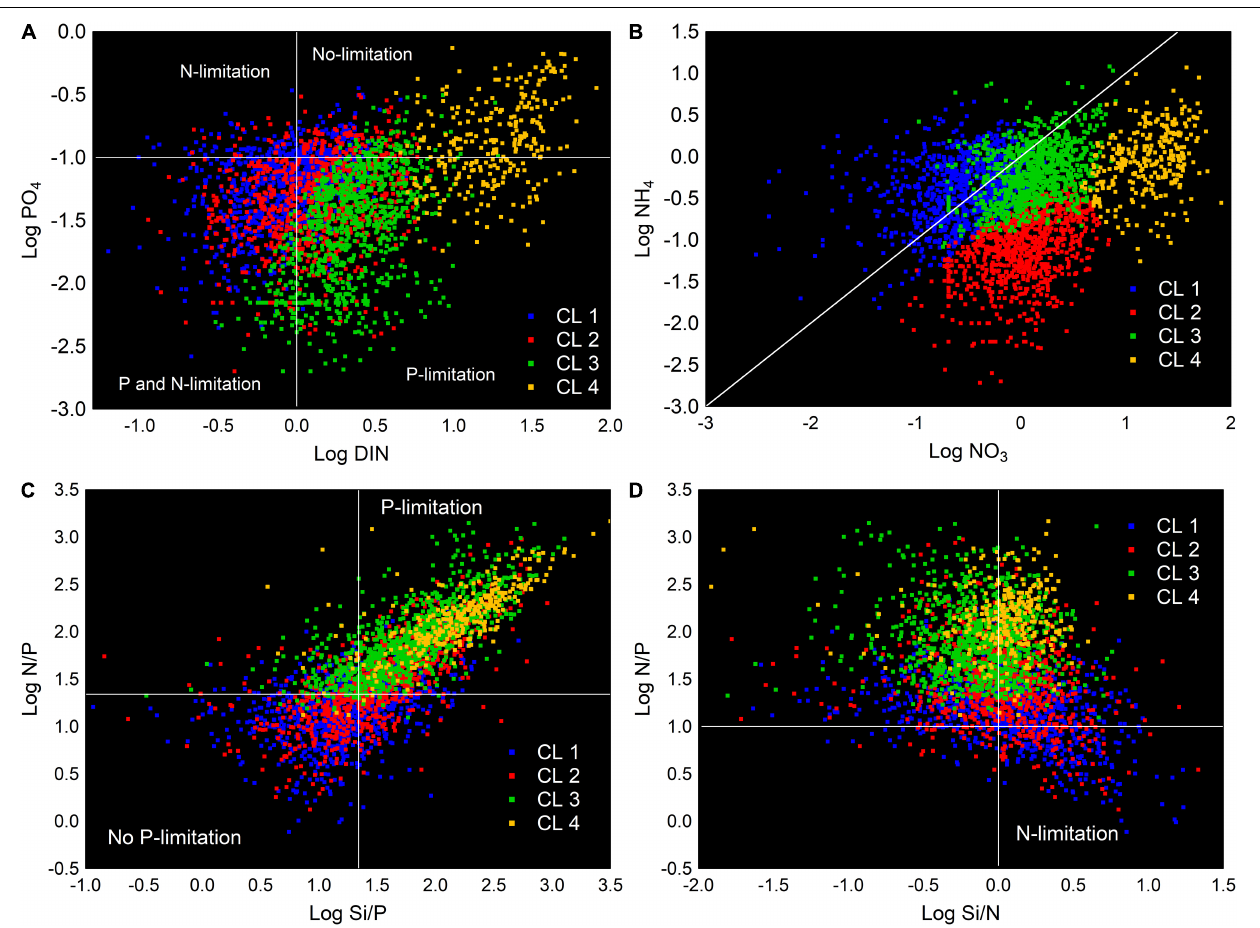
FIGURE 3 | Cluster mapping in relation to ambient nutrient concentrations (dissolved inorganic nitrogen and phosphorus), with concentrations likely limiting nutrient uptake (phosphorus limiting—below horizontal line, nitrogen limiting—left of vertical line) (A) . Cluster mapping in the scatter plot showing the relationship between ambient concentrations of allochthonous (NO3 − ) and regenerated (NH4 + ) nitrogen. A 1:1 line is indicated (B) . Cluster mapping in the atomic nutrient ratio framework with stoichiometric criteria for potential limitation of phosphorus (C) and nitrogen (D) . Concentration of nutrients are in µ M.